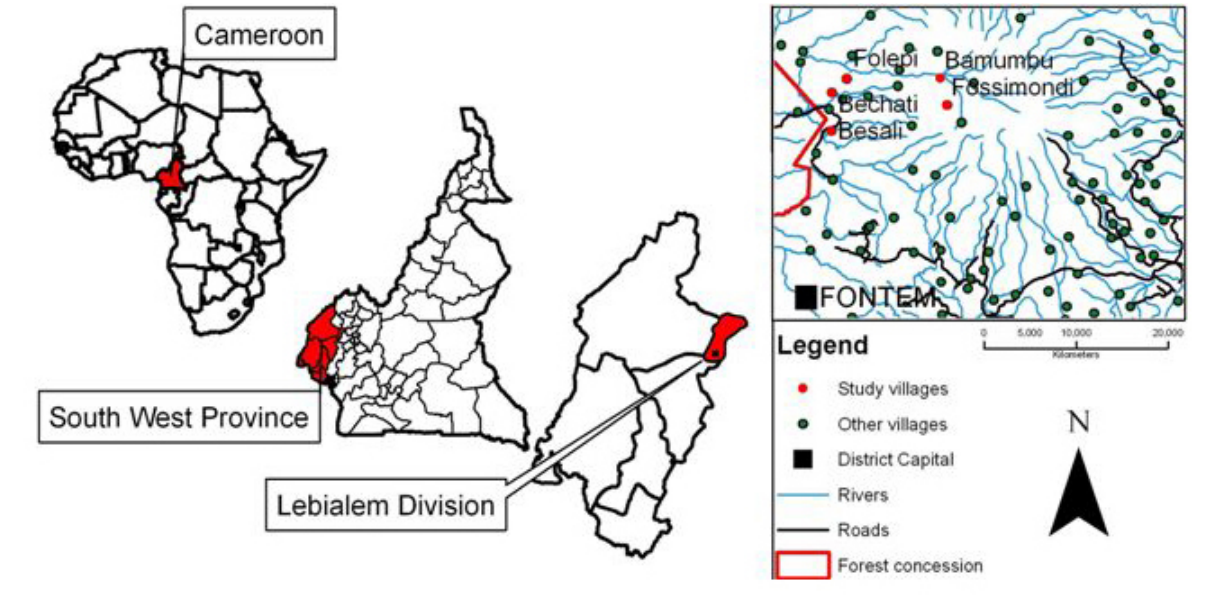
Fig. 1. Location of study areas showing continental, provincial, and village location. Map produced with assistance of